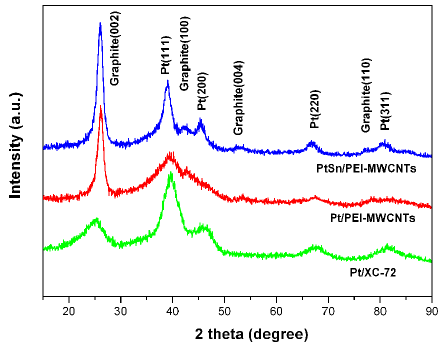
Figure 6. X ‐ ray diffraction patterns (XRD) of Pt/XC ‐ 72, Pt/PEI ‐ MWCNTs and PtSn/PEI ‐ MWCNTs. Figure 6. X-ray diffraction patterns (XRD) of Pt/XC-72, Pt/PEI-MWCNTs and PtSn/PEI-MWCNTs.